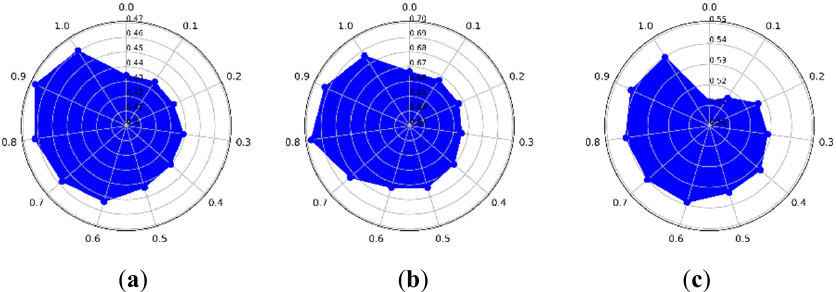
Figure 9. The impact of 𝛽 on the proposed CLAP. ( a ) Indian Pines dataset. ( b ) Pavia University dataset. ( c ) WHU ‐ Hi ‐ HongHu dataset.